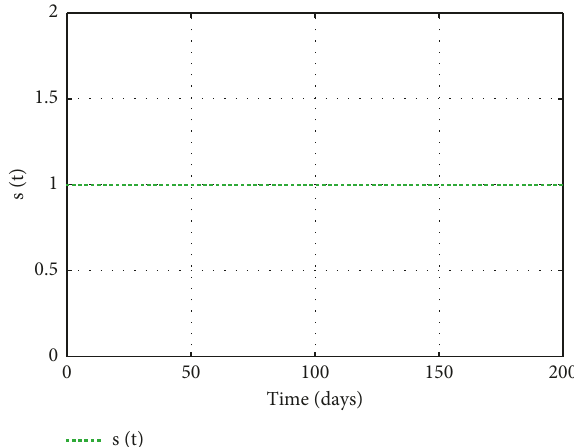
Figure 4: Numerical simulations of population dynamics with no